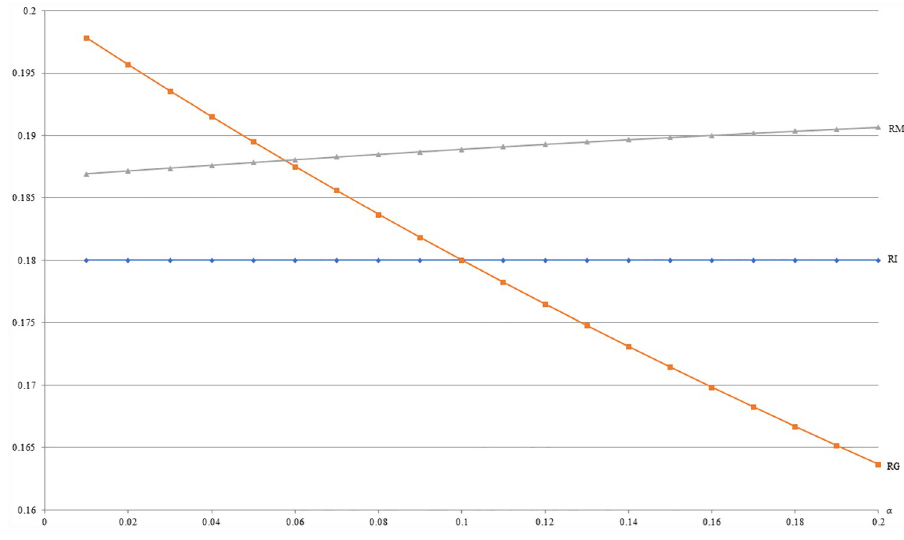
Fig 12. A comparison of revenues between IB, GB and MIX with respect to α .